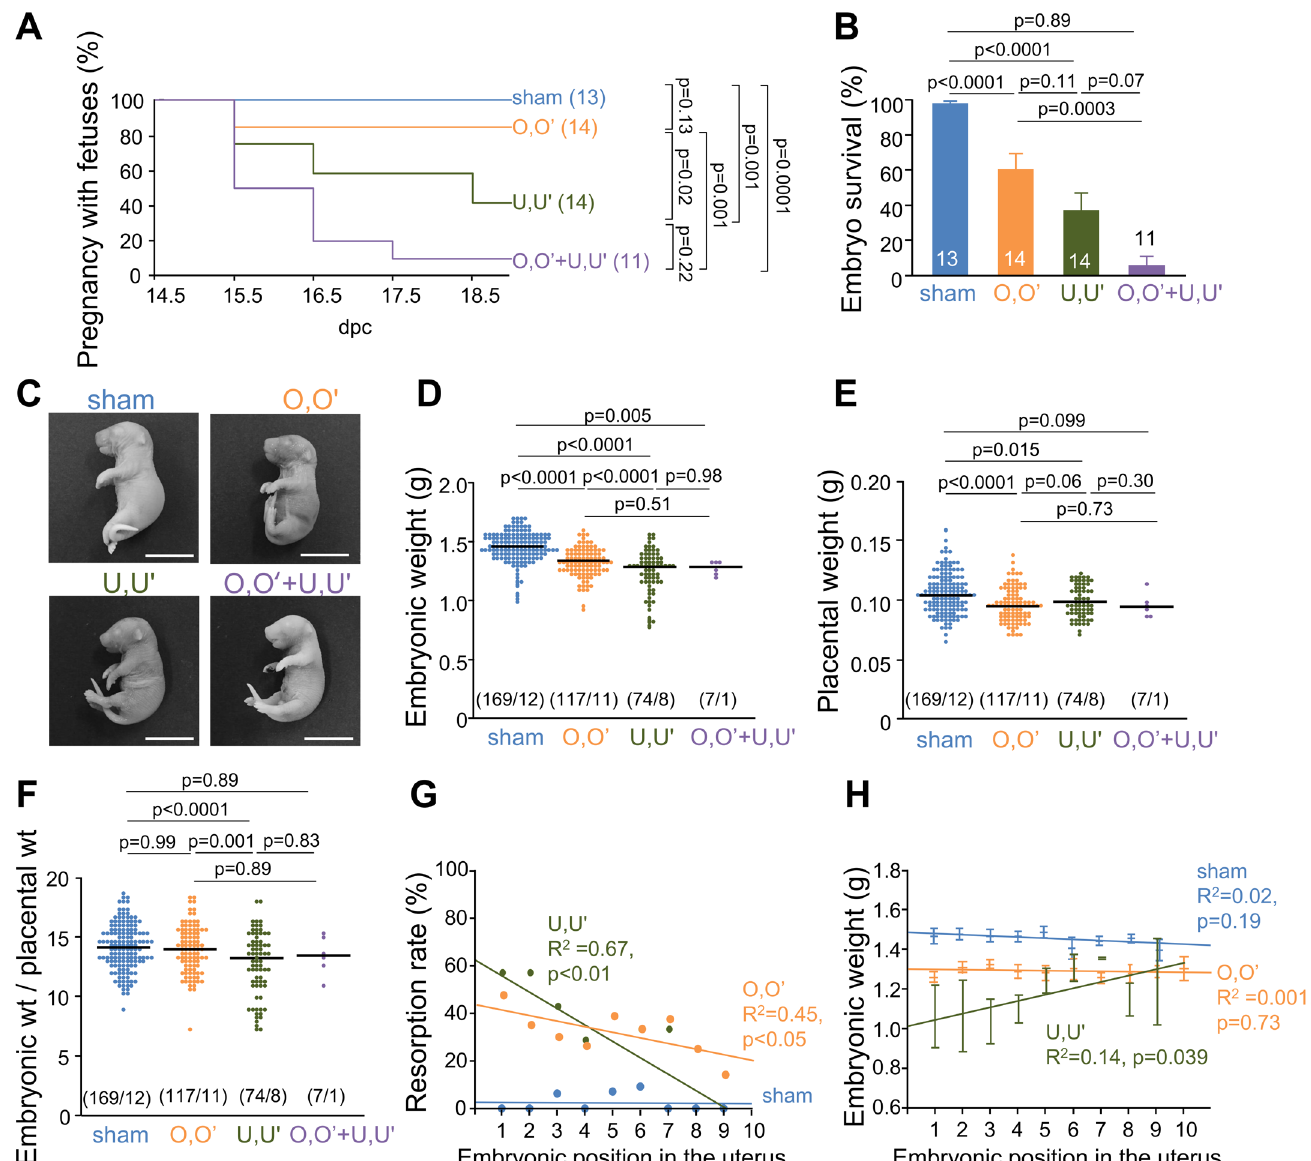
Fig 4. RUPP surgery causes miscarriages and embryonic growth restriction. ( A ) Continuing pregnancies with or without the ligation at 14.5 dpc; parentheses show number of pregnancies at 14.5 dpc. ( B ) Embryo survival from 14.5 dpc to 18.5 dpc. ( C ) Representative images of embryos. Bars, 1 cm. ( D ) Embryonic weight at 18.5 dpc; parentheses show number of embryos/number of dams. ( E ) Placental weight at 18.5 dpc. ( F ) Embryonic weight/ placental weight ratios. ( G ) Relationship between resorption rate and embryonic position in the uterus. ( H ) Relationship between embryonic weight and position in the uterus. Embryonic position was numbered from the position of